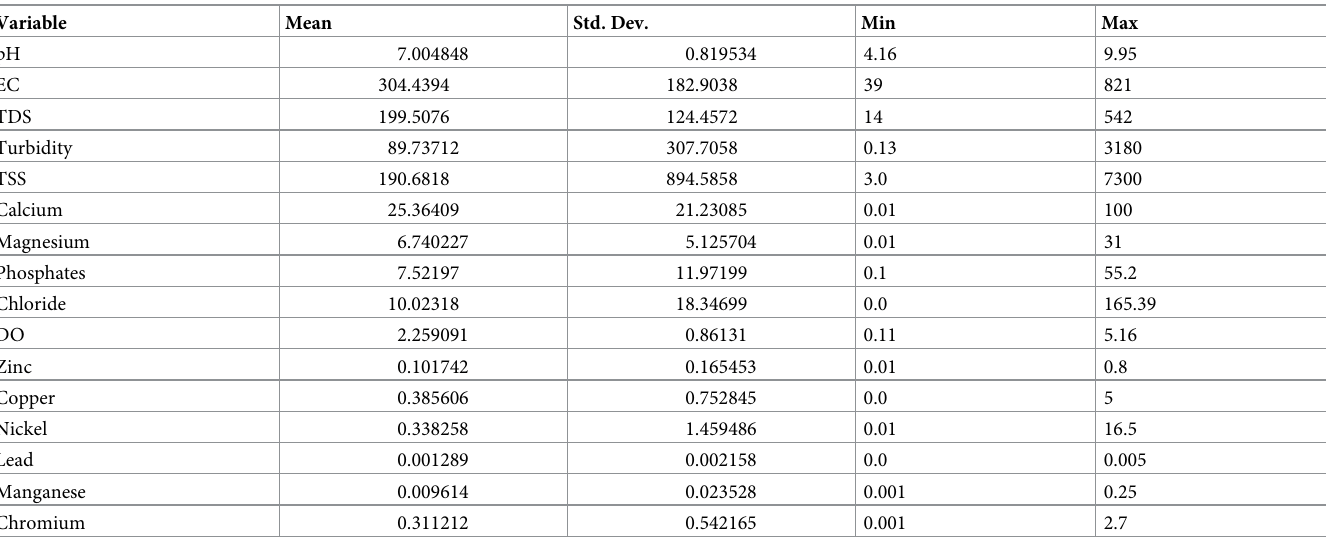
Table 1. Descriptive statistics of surface water samples (n = 132).